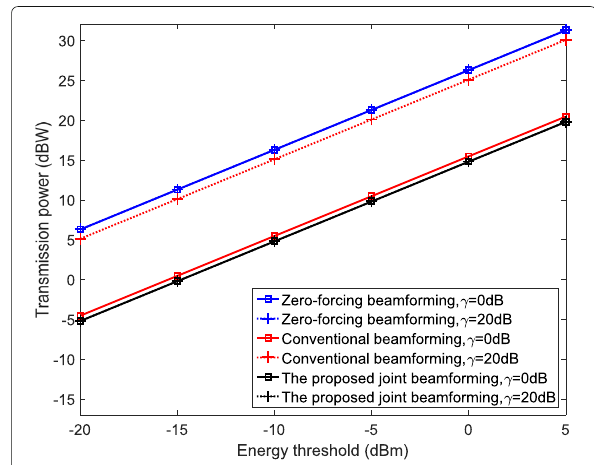
Fig.6 The relation between transmission power and energy threshold